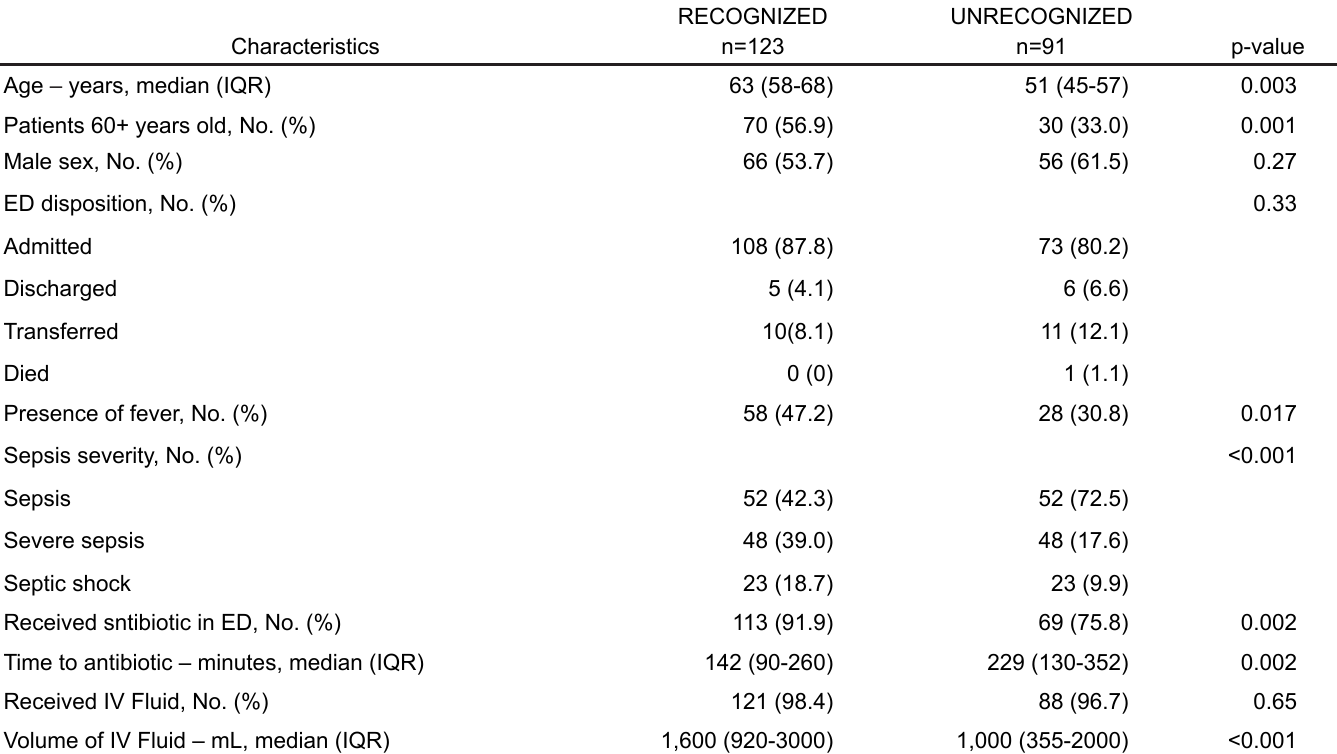
Table 2. Characteristics of patients with sepsis by RECOGNIZED vs. UNRECOGNIZED